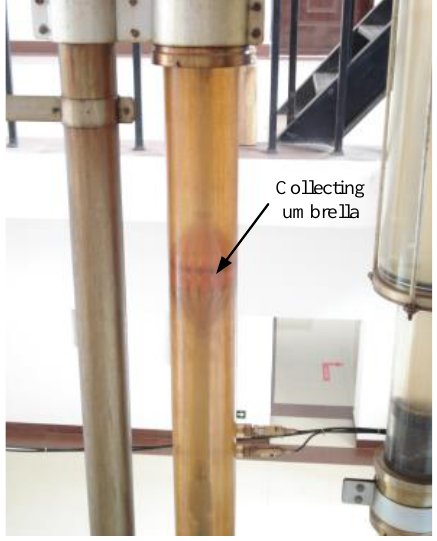
Figure 13. DGLS multiphase flow experiment device.